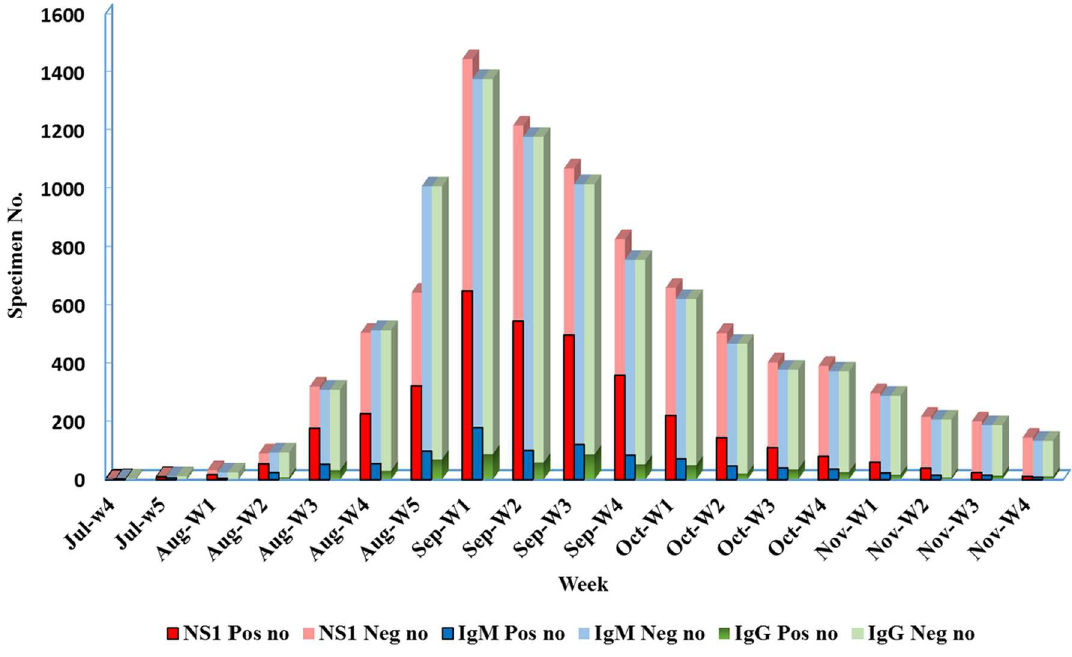
Fig 1. Detection of dengue virus (DENV) NS1 antigen and DENV-specific IgM and IgG antibodies at the Clinical Virology Laboratory of the National Cheng Kung University Hospital (NCKUH) between July and November 2015. (Pos: Positive; Neg: Negative; no: